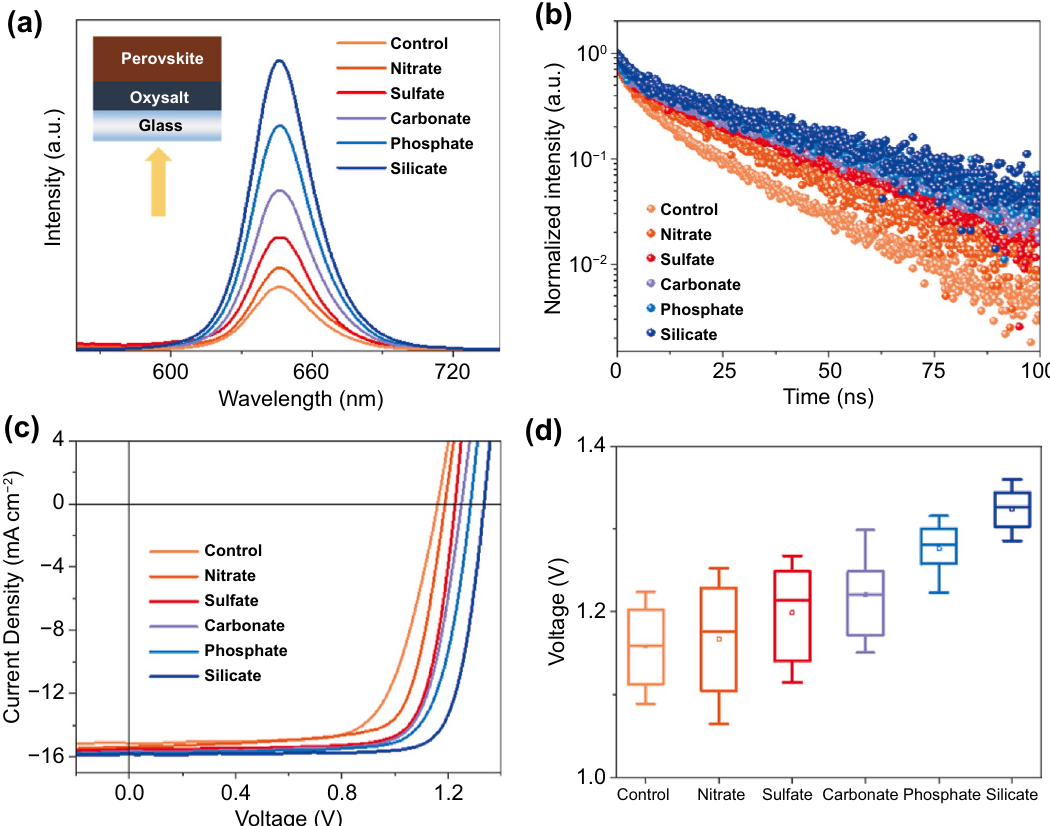
Fig. 3 a Steady-state PL and b TRPL decay spectra of CsPbI 2 Br perovskite films without and with oxysalt passivation layer. Inset is the sche- matic of the PL measurement of the perovskite films. The excitation light of was irradiated from the glass side for the PL tests. c J–V curves and d V OC distribution of CsPbI 2 Br solar cells without and with oxysalt passivation. For each kind of device, the solid transverse lines in the boxes are the average PCEs analyzed from 20 individual devices, and the error bars show the highest and lowest PCE